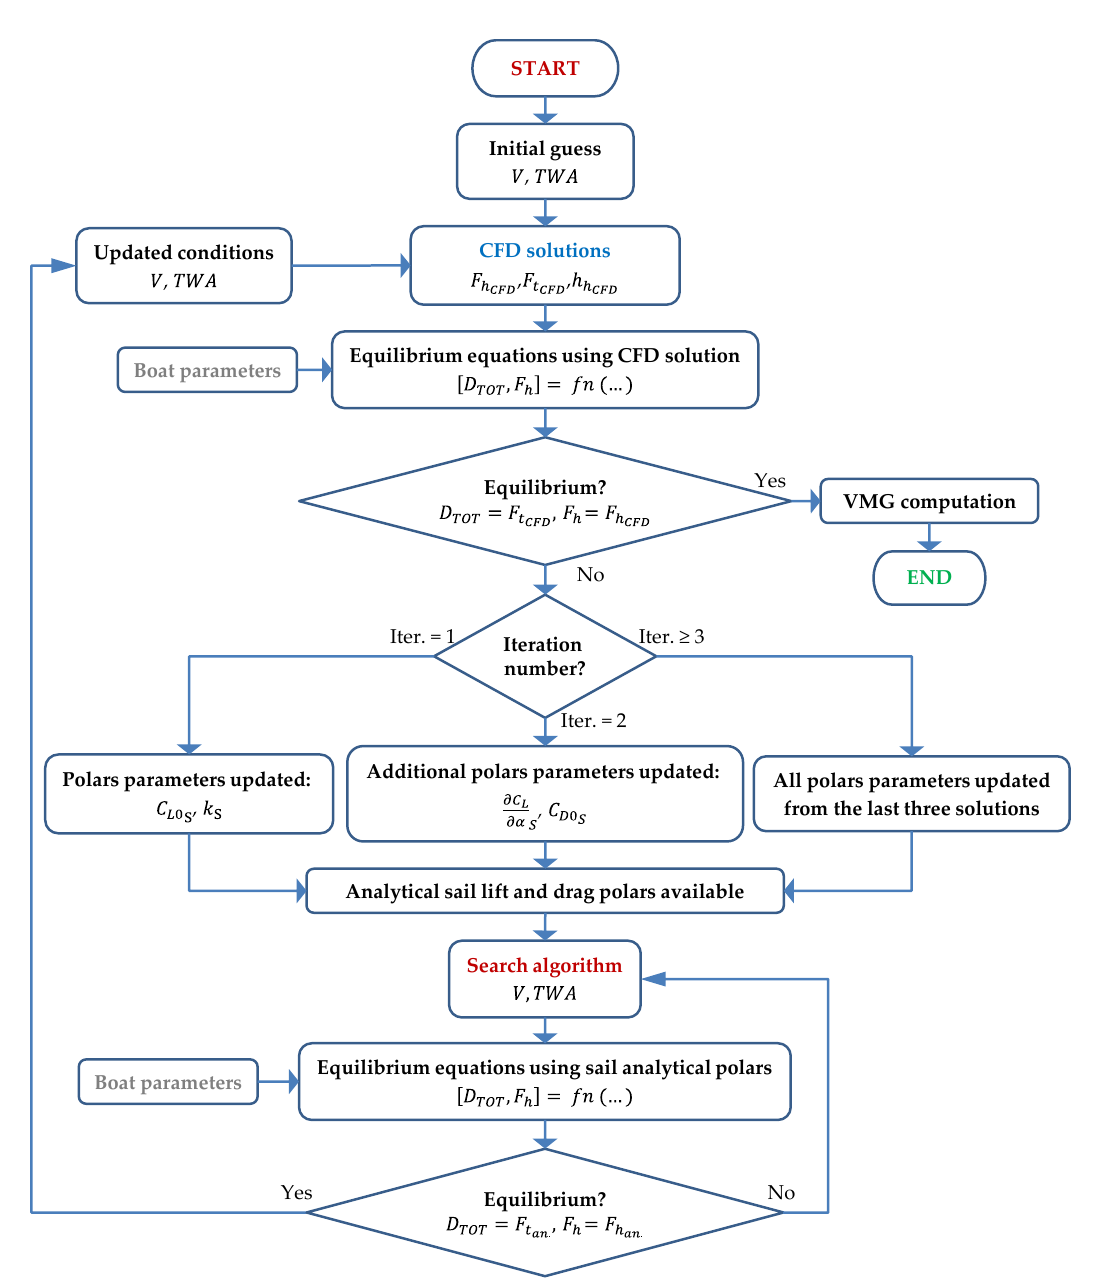
Figure 11. Flow chart of the VPP module.